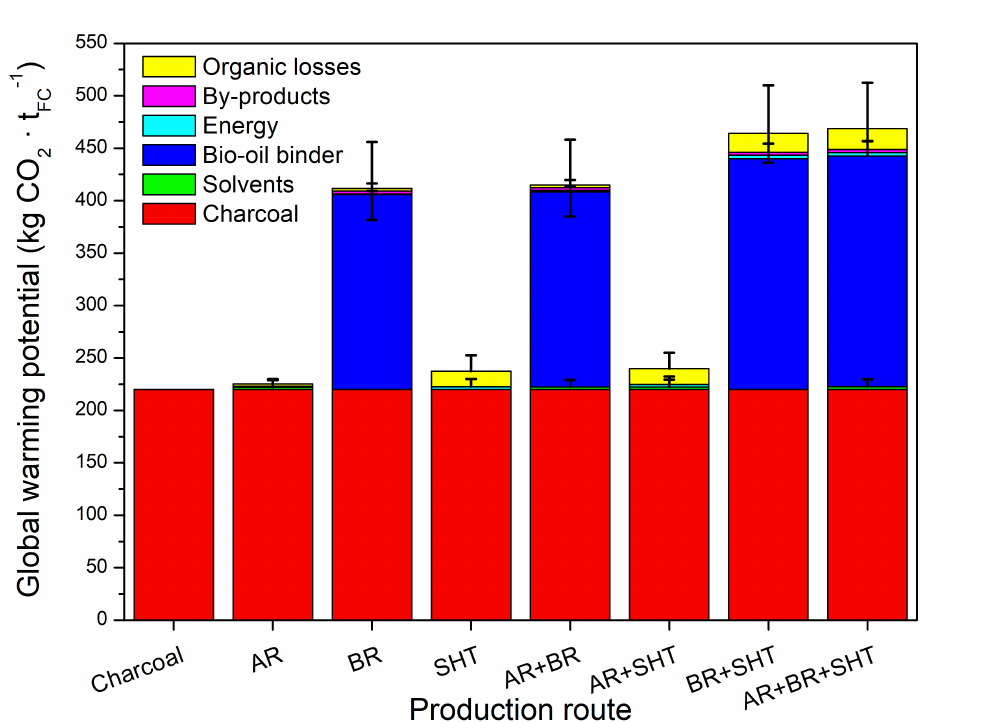
Figure 6. Global warming potential of ash reduced charcoal, briquettes and renewable coke on basis of renewable energy and sustainable chemical supply. Industrial charcoal is used as reference